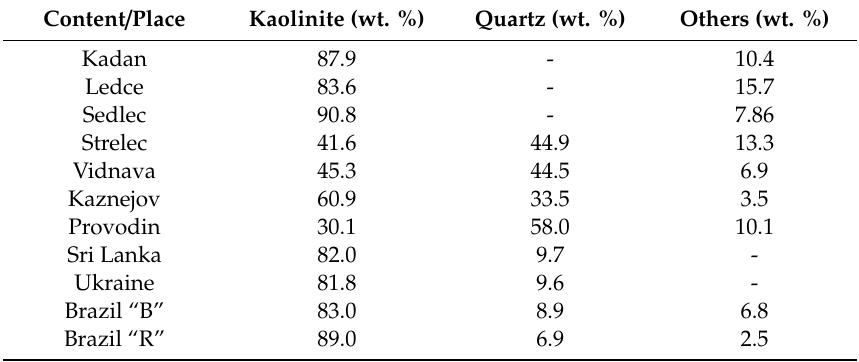
Table 4. The Calculated Theoretical Content of Kaolinite and Quartz in Clay Samples. Content / Place Kaolinite (wt. %) Quartz (wt. %) Others (wt. %) Kadan